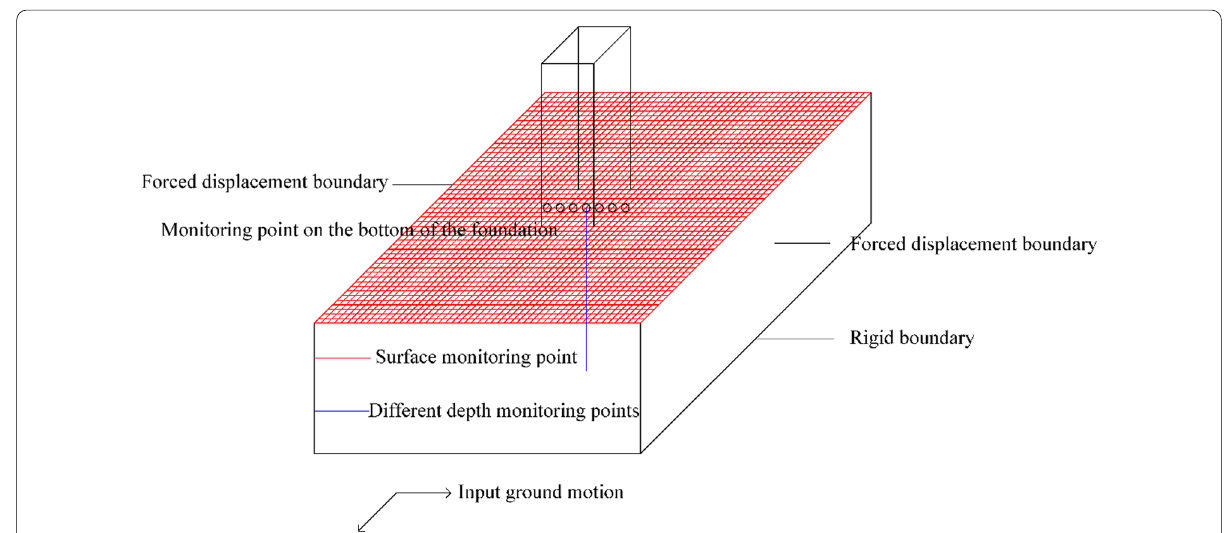
Fig. 1 Schematic diagram of a three-dimensional model of soft soil site